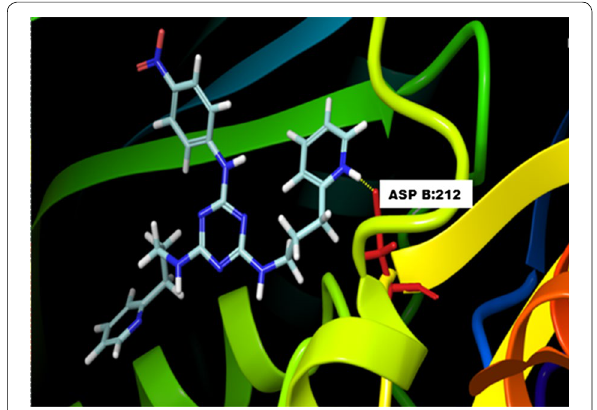
Fig. 1 3-D docked for binding of compound no 18 in the active site of